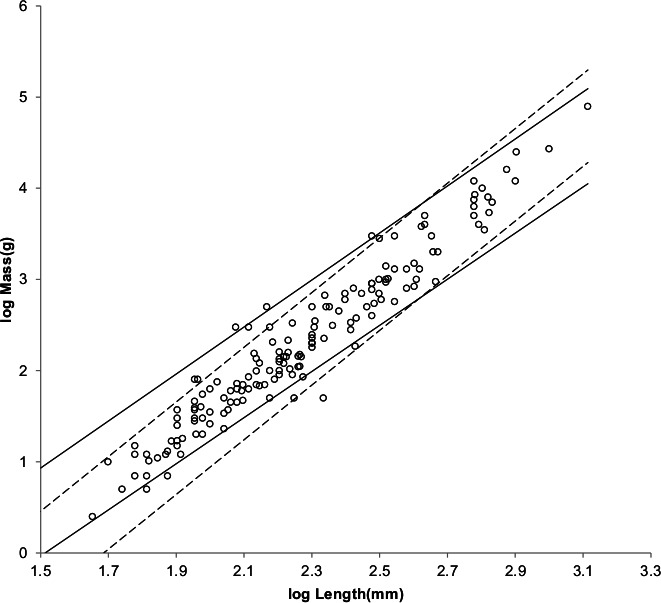
Log body mass as a function of log head and body length for non-cricetid rodents.Data are from Nowak (1999). The solid and dashed lines are MMLE sturdiness factor boundaries. The upper boundaries were generated with a sturdiness factor s = (3)0.5. The lower boundaries were generated with s = (3)−0.5. The shallower sloping solid boundary lines are for Froude–Strouhal similarity. The steeper sloping dashed boundary lines are for geometric similarity. Non-cricetid rodents are marked by open circles. \documentclass[12pt]{minimal}
\usepackage{amsmath}
\usepackage{wasysym}
\usepackage{amsfonts}
\usepackage{amssymb}
\usepackage{amsbsy}
\usepackage{upgreek}
\usepackage{mathrsfs}
\setlength{\oddsidemargin}{-69pt}
\begin{document}
}{}${R}_{M}^{2}=0.9995$\end{document}RM2=0.9995 with respect to both sets of boundaries.